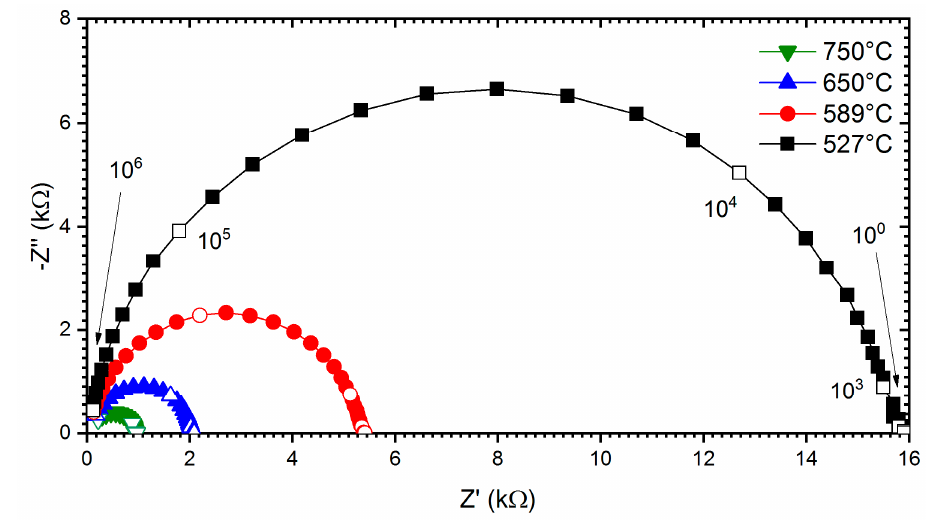
Figure 7. Nyquist plots of impedance measured on the SST5 sample under O 2 and at different temperatures. Open markers point at frequency decades (Hz) on all plots.